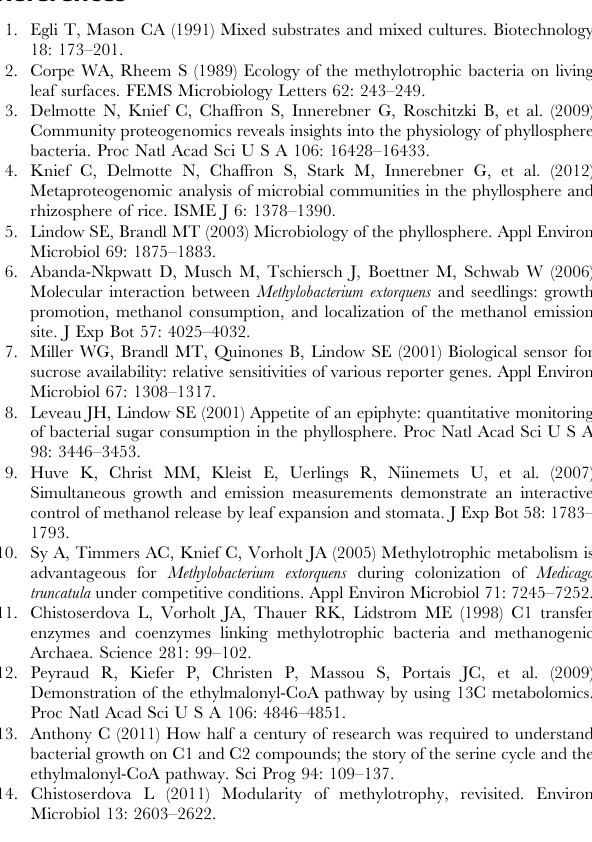
Figure S5 Scheme of the Coenzyme A biosynthesis in M. Table S1 Lists of parameters used for flux balance analysis and flux variability analysis. Table S2 List of the reactions reduced for flux balance analysis upon co-consumption condition. Table S3 Fluxes solution of the feasibility analysis. Table S4 Fluxes solution of the flux variability analysis. Table S5 Details of energetics calculations from flux balance